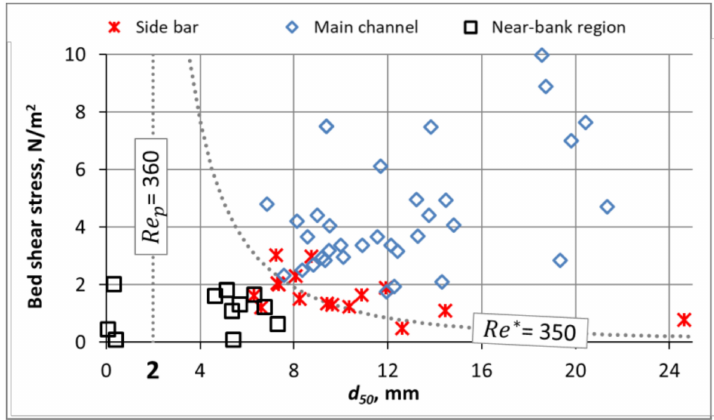
Figure 5. The bed shear stress as the function of the d 50 grain size, regarding field and laboratory measurements